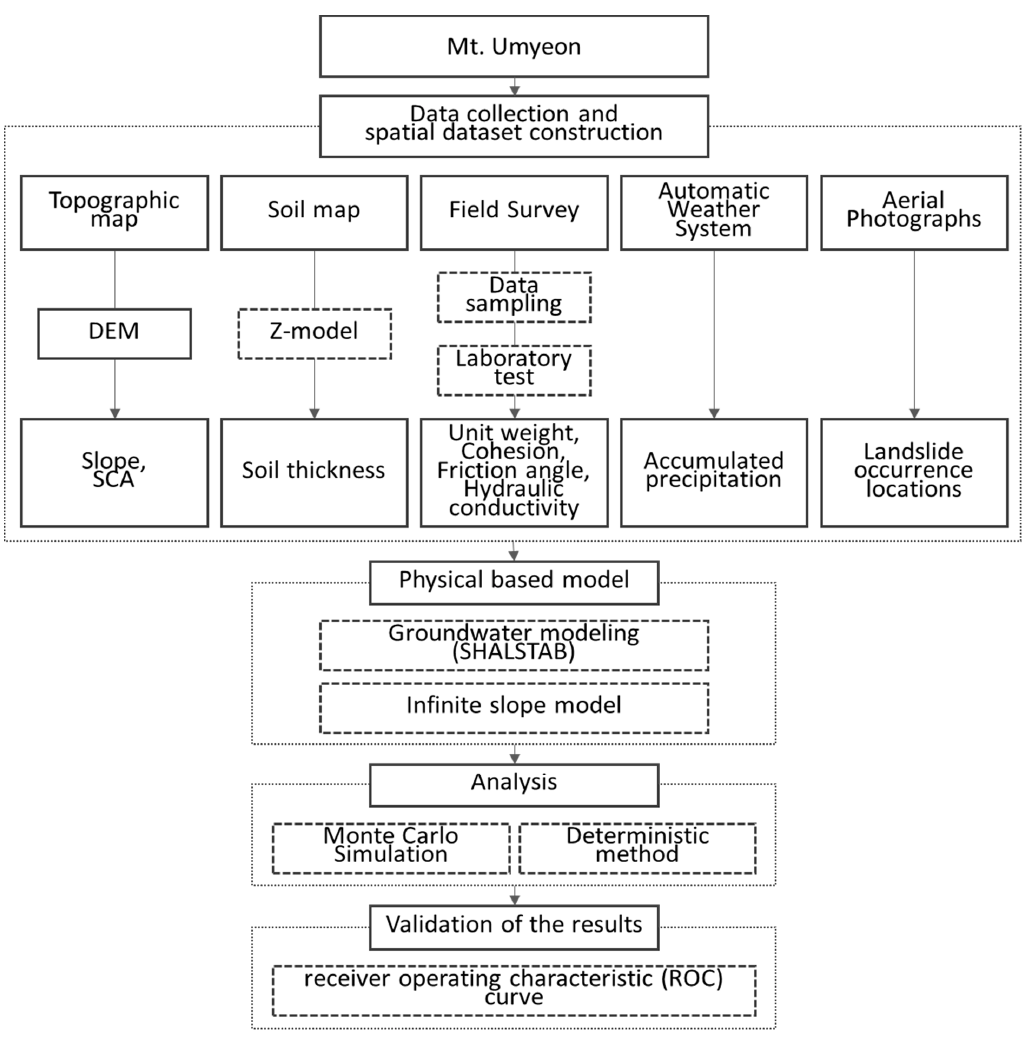
Figure 1. The workflow of this study.